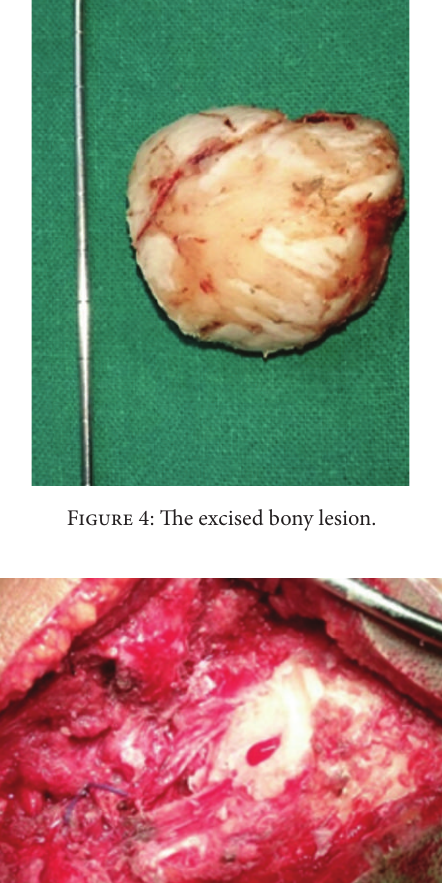
Figure 1: Image showing the extent of lesion and the planned surgical incision mark.